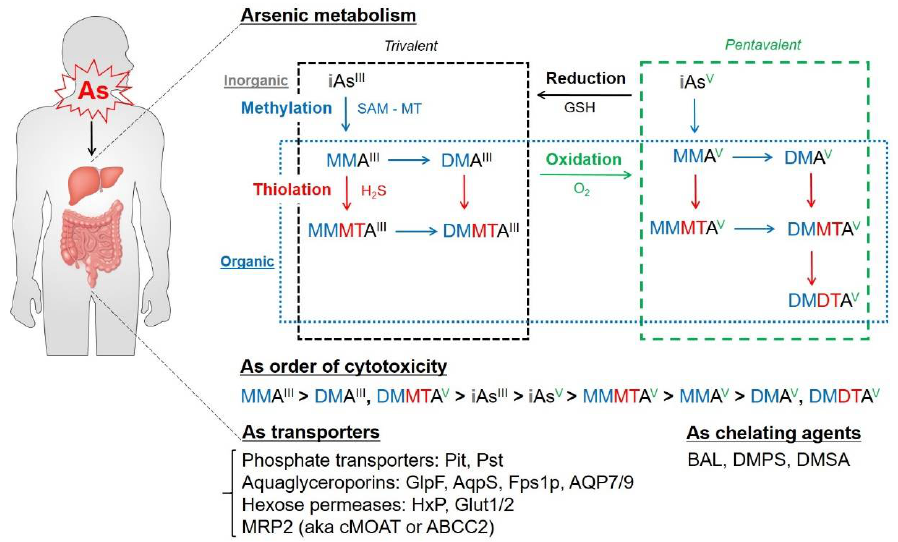
Figure 1. Biotransformation of arsenic in the human body. Once arsenic (As) is absorbed through the gastrointestinal tract and lungs from air, water, food and the environment, various As species are generated by biotransformations, such as methylation and thiolation. As converts its oxidation states between pentavalent (+5) and trivalent (+3) via the reduction and oxidation processes in the human body. As is transported via aquaglyceroporin channels on cellular membranes and mobilized through the bloodstream. Toxic As species are detoxified in the liver and secreted through urine. However, As species over the detoxification threshold of the liver can be further mobilized and accumulated in the human body for several months or even longer. As-chelating agents such as BAL, DMPS and DMSA are frequently used for clinical and therapeutic purposes against acute As exposure and